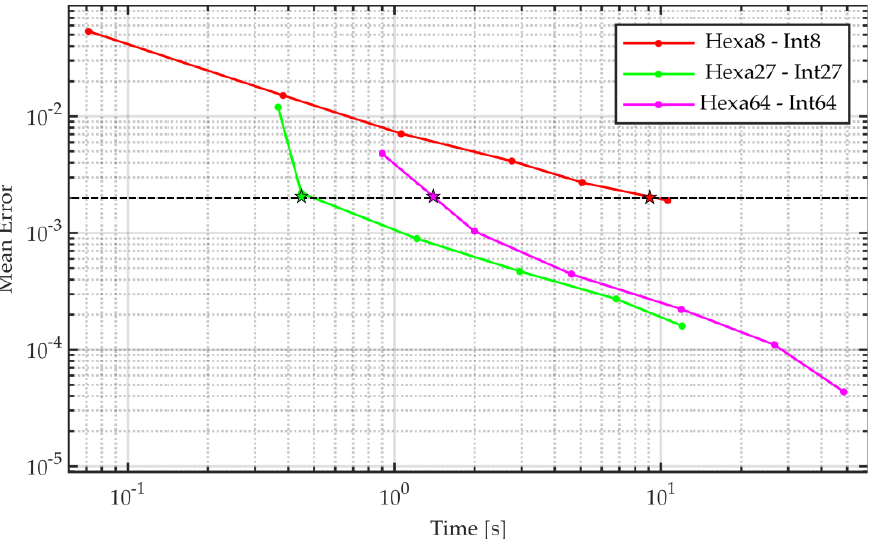
Figure 5. Convergence analysis of full − order linear, quadratic, and cubic FE formulations as a function of the assembly time.